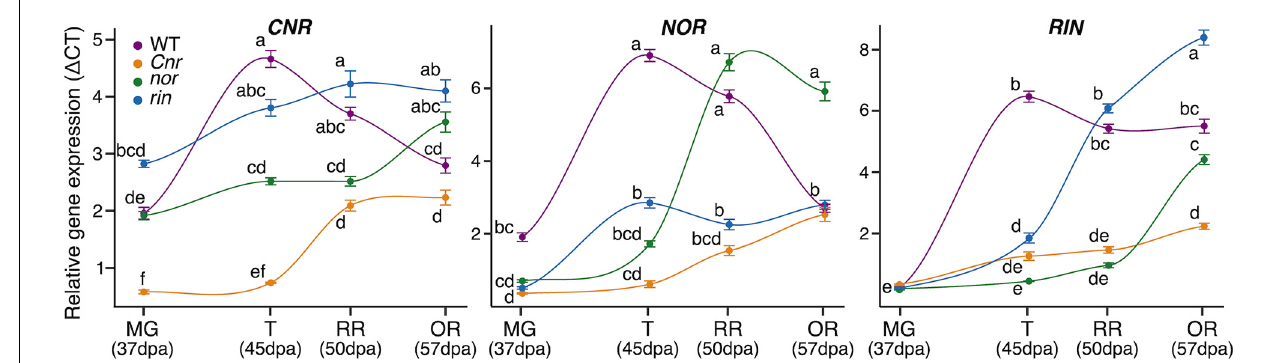
FIGURE 4 | Impact of ripening mutations on the CNR , NOR , and RIN transcription factors. Relative gene expression of the three transcription factors across ripening in the wild type (WT), Cnr , nor , and rin genotypes measured by quantitative reverse transcription (qRT)-PCR. The measurements were done with fruit ( n = 6) collected at 37 days post anthesis (dpa), equivalent to the mature green stage (MG), 45 dpa, equivalent to the turning stage (T), 50 dpa, equivalent to the red ripe stage (RR), and 57 dpa, equivalent to the overripe (OR) stage. Error bars represent standard error between biological replicates of each sample. Letters indicate significant differences among genotypes and ripening stages calculated by ANOVA and Tukey HSD ( P ≤